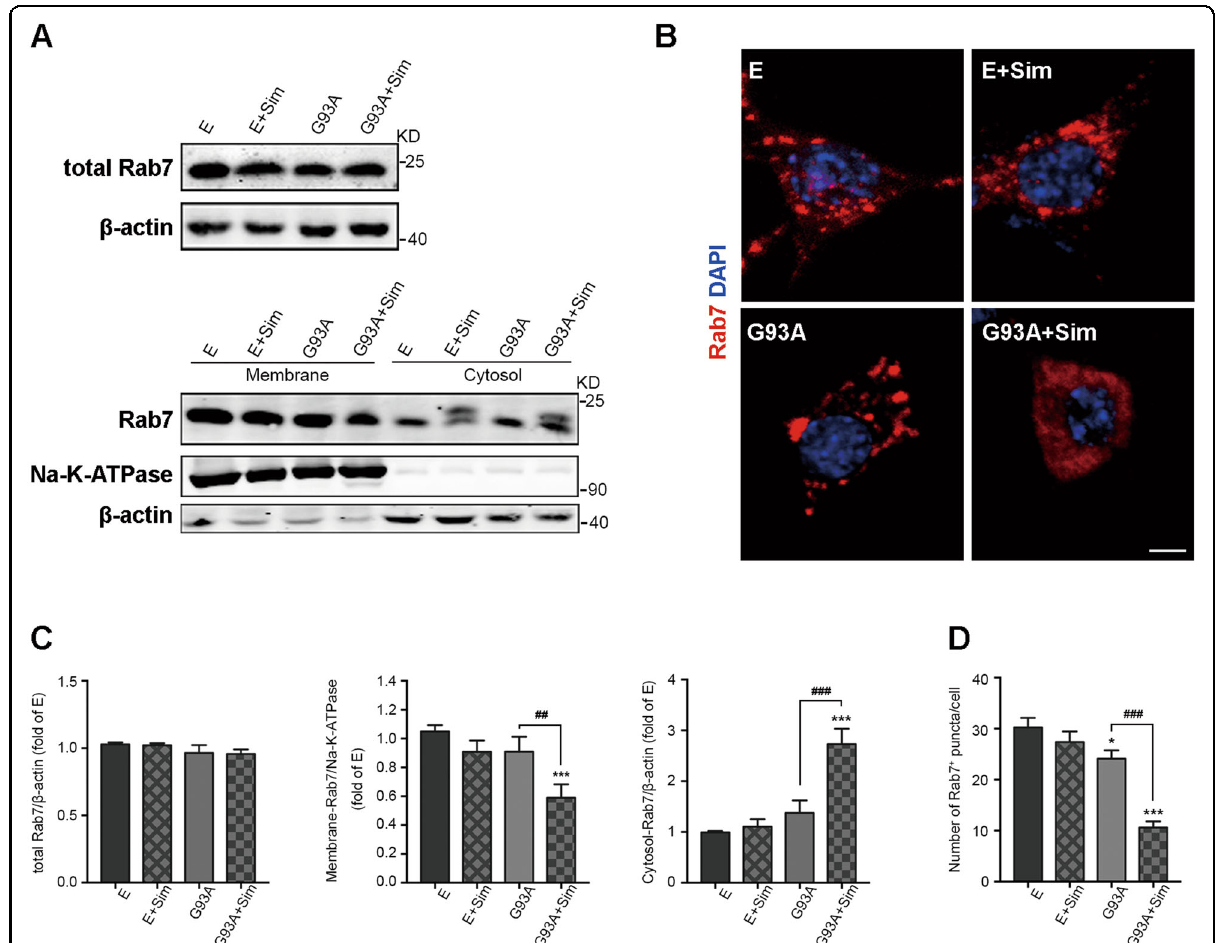
Fig. 6 Simvastatin inhibited Rab7 localization to membranes in NSC34-hSOD1 G93A cells. A The expression of Rab7 protein in total cell, membranes, cytosol for each group by western blot analysis. NSC34-E and NSC34-hSOD1 G93A cells were incubated with Simvastatin (1 µM) for 24 h. B Rab7-positive structures (red) in NSC34-E and NSC34-hSOD1 G93A cells treated or untreated with simvastatin (1 µM) for 24 h. Nuclei were stained with DAPI (blue, Scale bars, 5 μ m). C Quanti fi cation of Rab7 protein in total cell, membranes, cytosol for each group. D Quantitative analysis of intracellular Rab7 puncta in each group. (Data represent the mean ± SEM, n = 20 cells per group; statistical signi fi cance was assessed by one-way ANOVA or an unpaired t -test, * P ≤ 0.05, ** P ≤ 0.01, *** P ≤ 0.001, # P ≤ 0.05, ## P ≤ 0.01, ### P ≤